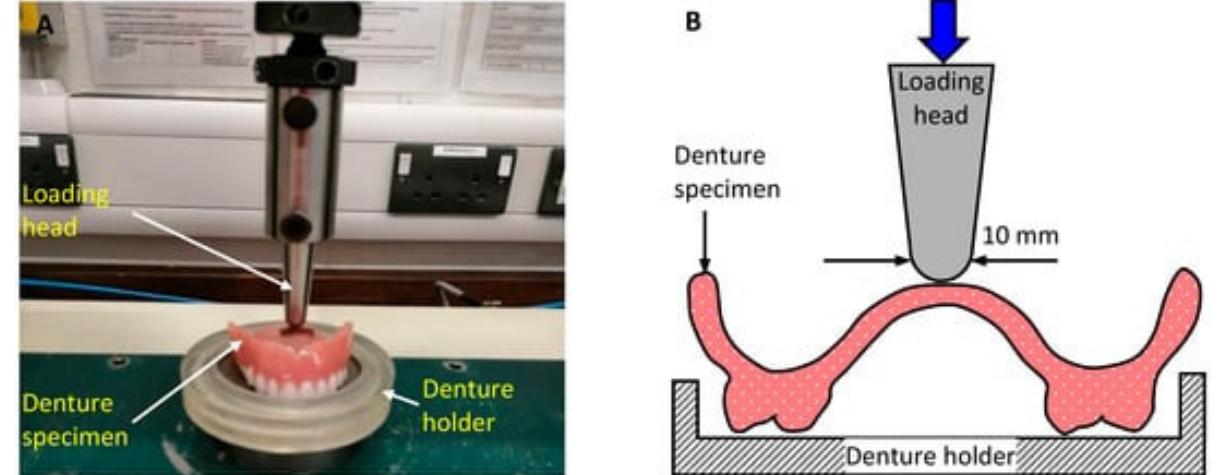
Figure 6. ( A ) Application of bending load on the palatal surface of PMMA/ZrO 2 denture specimen using a Hounsfield universal testing machine and ( B ) schematic diagram of loading conditions. Reprinted from ref. [12], copyright 2020, MDPI.